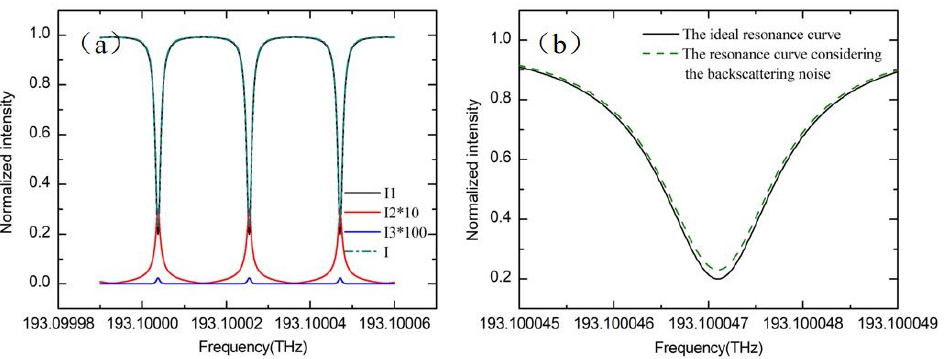
Figure 11. ( a ) Resonance characteristics of the I 1 , I 2 , and I 3 when gyro is static. ( b ) The influence of the backscattering noise on the resonance depth.